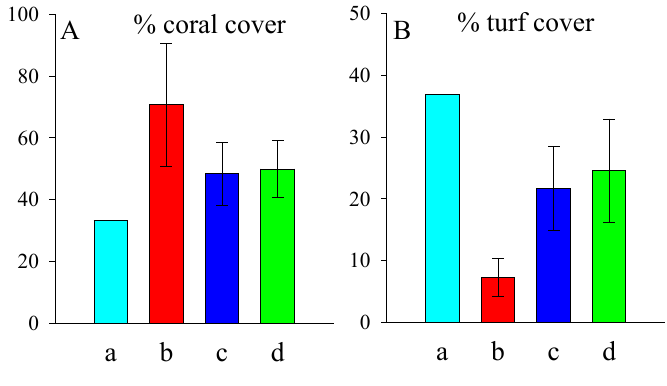
Figure 4. Bar graphs showing the mean percentage of ( A ) coral and ( B ) turf cover across the 4 site groups chosen using CLUSTER analysis. Aqua bars represent sites in group A, red bars represent sites in group B, blue bars represent sites in group C and green bars represent sites in group